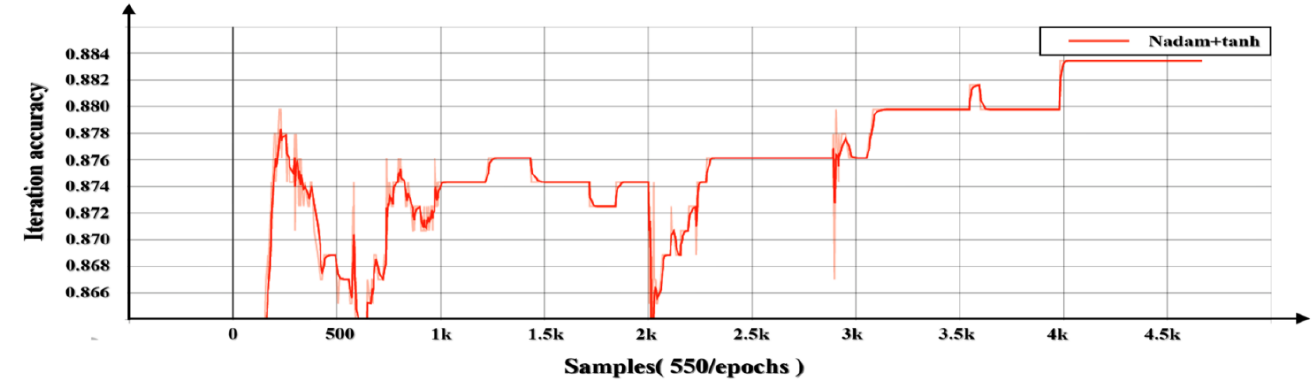
Figure 12. The precision for the solution of Nadam+tanh.